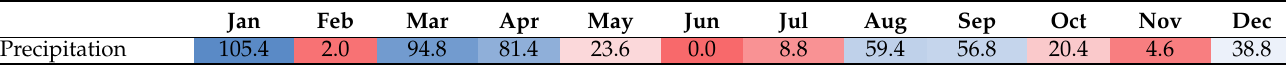
Table 8. Rain (mm). Source: AEMET (State Meteorological Agency of